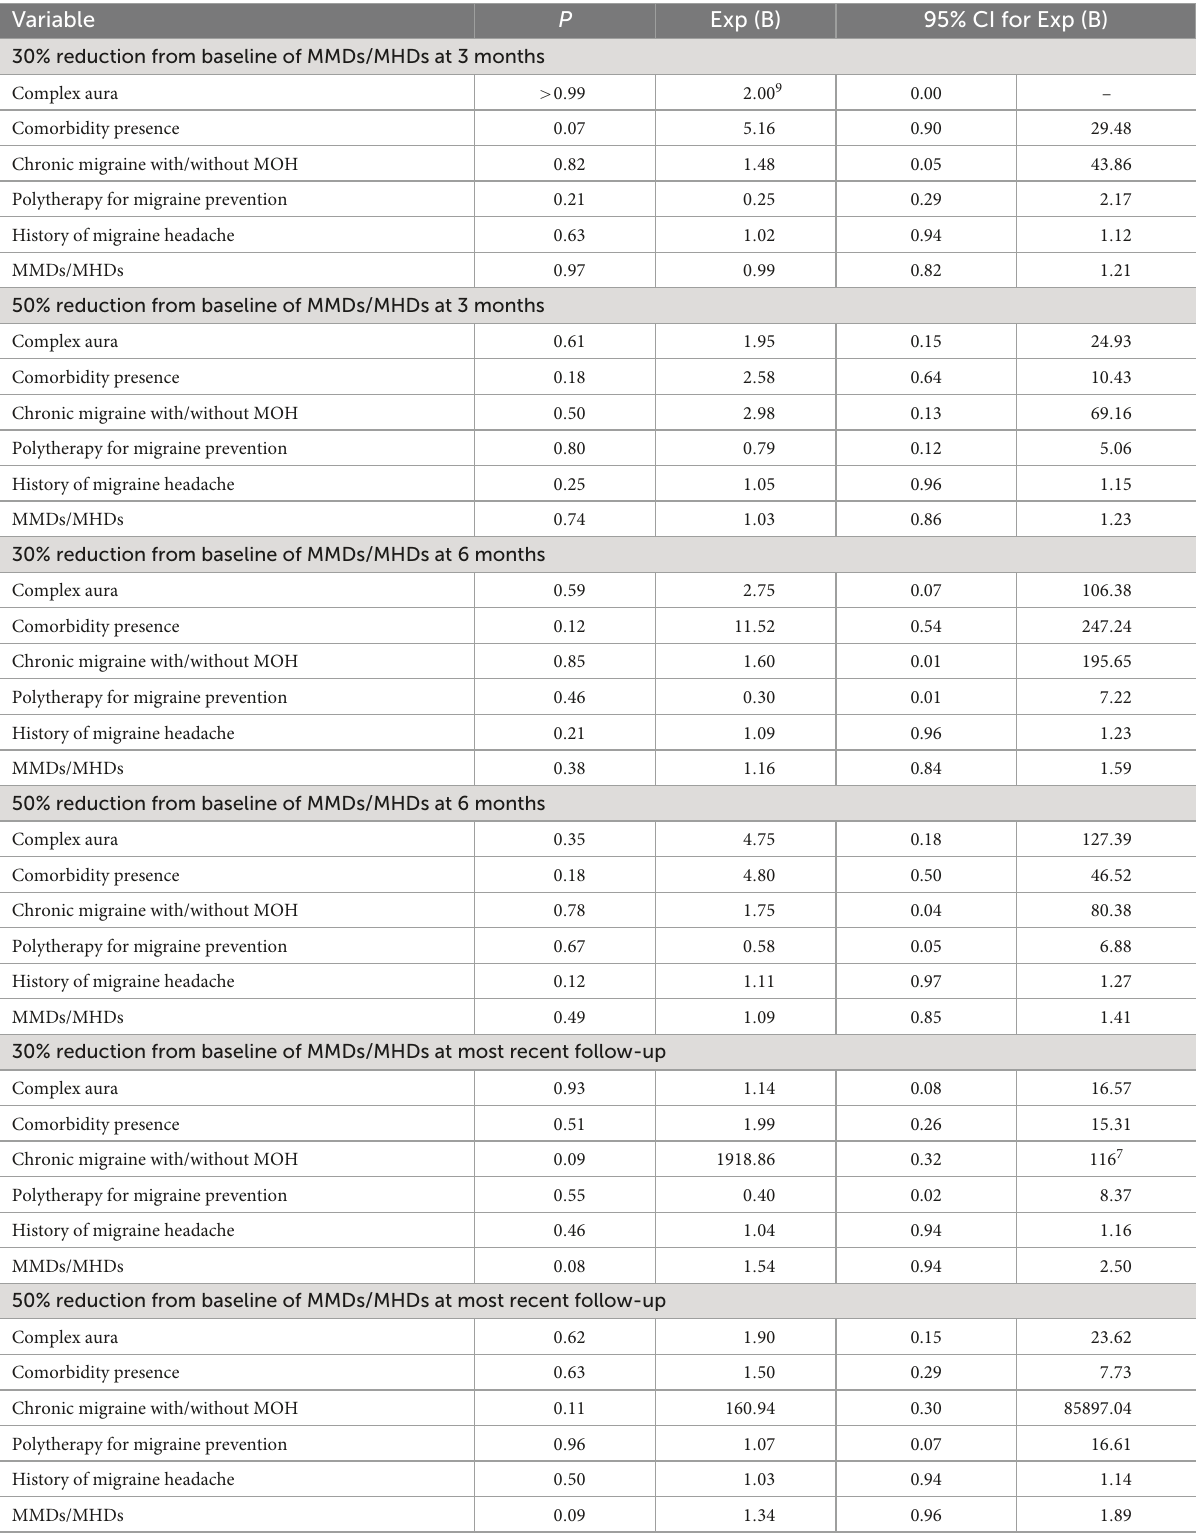
TABLE 4 Binary logistic regression of treatment outcomes with an adjustment for migraine subtypes, aura subtypes, number of preventive medications used and comorbidity. Variable P Exp (B) 95% CI for Exp (B) 30% reduction from baseline of MMDs/MHDs at 3 months Complex aura > 0 .